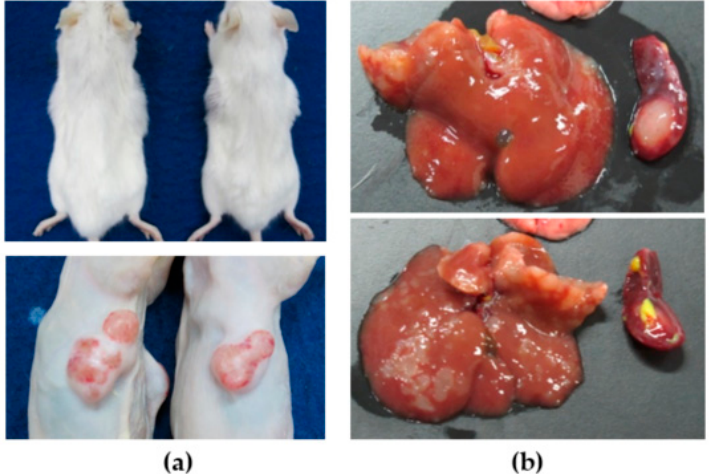
Figure 5. CCA cell line transplantation in subcutaneous ( a ) and intrasplenic ( b ) xenograft mouse models. The representative pictures are from KKK-D068 transplantations. Table 3. PDX-derived cell line transplantation rate in subcutaneous (SC) and intrasplenic (IS) xenograft mouse